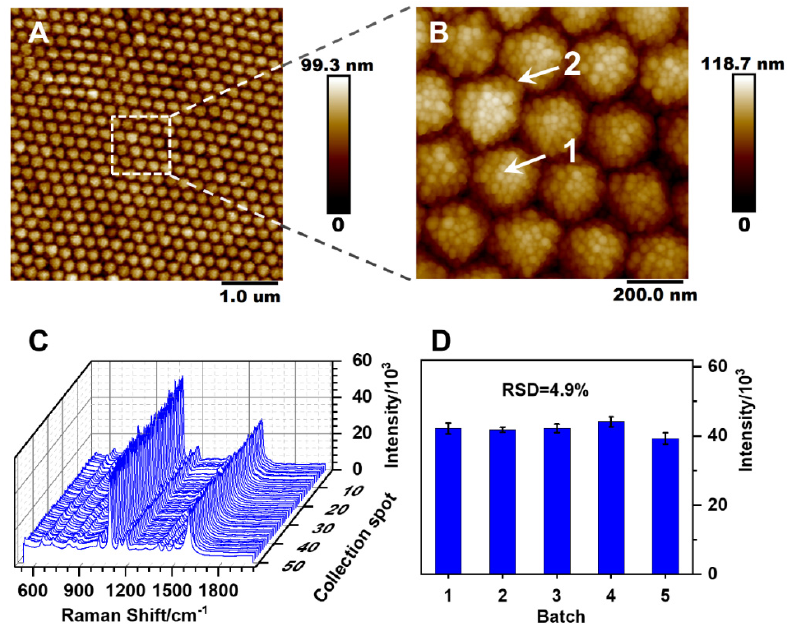
Figure 5. ( A , B ) AFM images of a SiO 2 @nAg-assembled monolayer PC substrate on a silicon slide, ( C ) 50 SERS spectra collected from different locations on the same PC substrate, and ( D ) the statistical deviation of SERS intensities of pATP at 1087 cm − 1 acquired from five different PC substrates assembled in five batches.